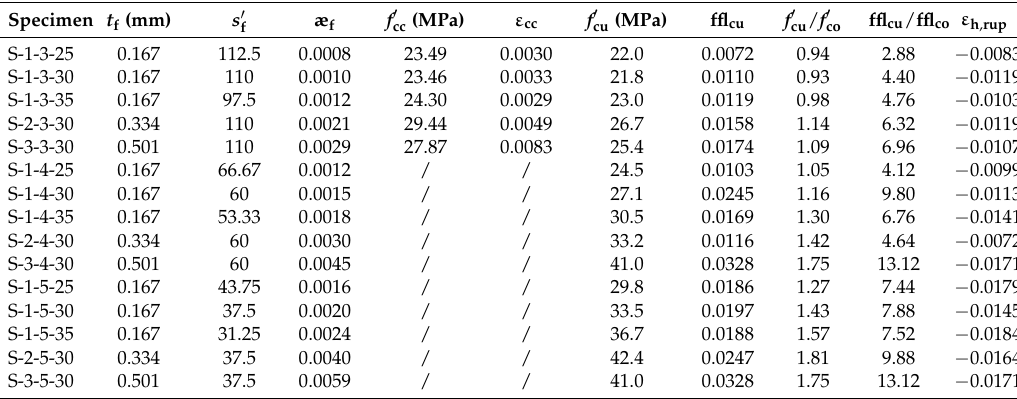
Table 1. Key information of test columns and key test